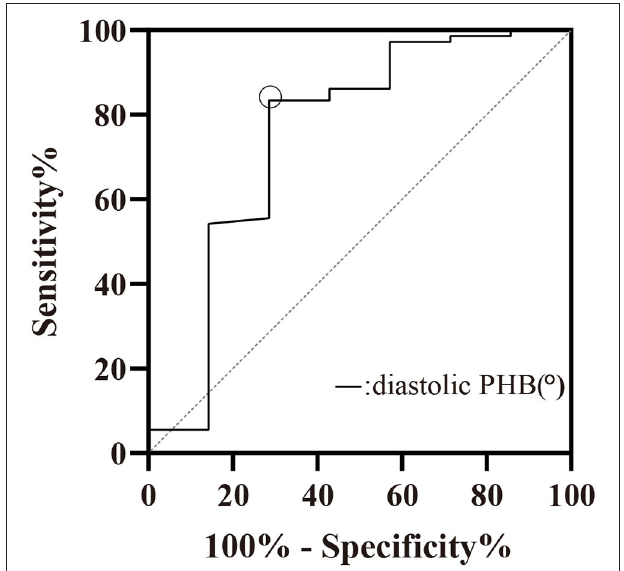
FIGURE 4 | ROC curve of diastolic PHB ( ◦ ) for the prediction of myocardial scar. Cut-off value: diastolic PHB > 204.5 ◦ , Sensitivity = 83.33%, Specificity = 71.43%. PHB, phase histogram bandwidth.